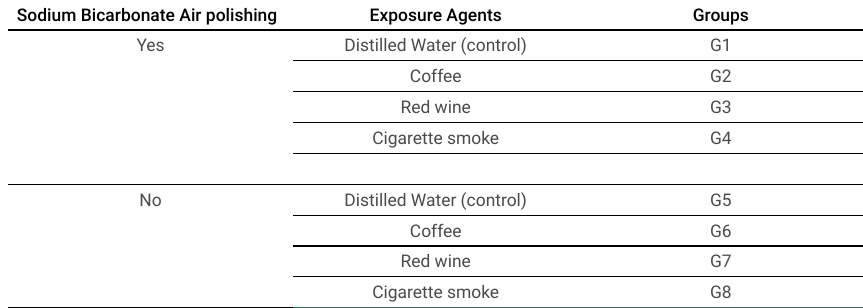
Table 1. Groups according to the surface treatment and the staining